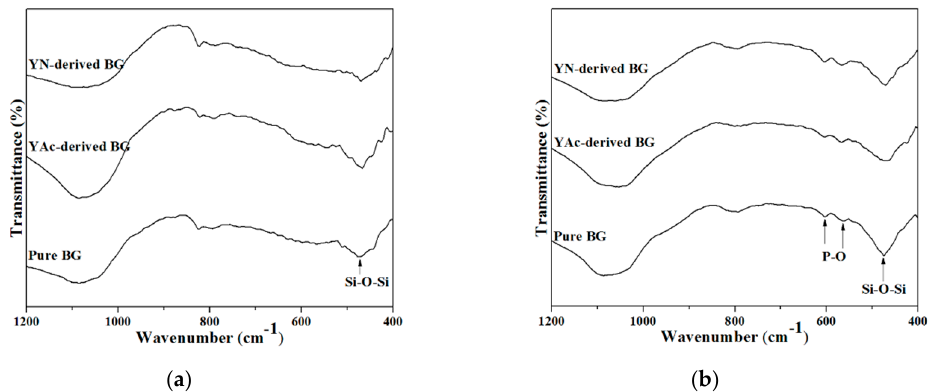
Figure 6. FTIR spectra of pure BG powder, and YAc- and YN-derived Y-doped BG powders: ( a ) before and ( b ) after immersion in SBF solution for 6 h.